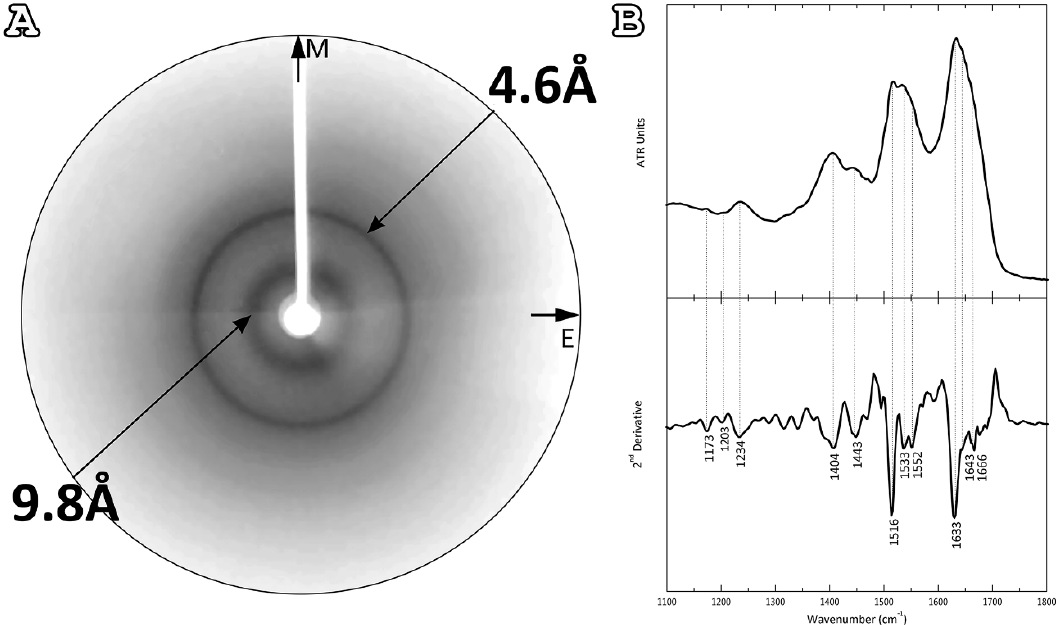
Figure 3. Structural features of AtPNP-A 36–69 fibrils. ( A ) X-ray diffraction pattern produced by oriented fibers containing AtPNP-A 36–69 amyloid fibrils. The pattern is indicative of the “cross- β ” structure, displaying both a meridional (M) 4.6 Å and an equatorial (E) 9.8 Å reflection, corresponding to the distance between consecutive β -strands and the distance between packed β -sheets, respectively. The random packing of the fibrils results in the occurrence of rings instead of oriented reflections. ( B ) ATR FT-IR (1100–1800 cm − 1 ) spectra results, obtained from suspensions of fibrils, produced from the AtPNP-A 36–69 , cast on a flat stainless-steel plate and left to air-dry slowly, at ambient con-